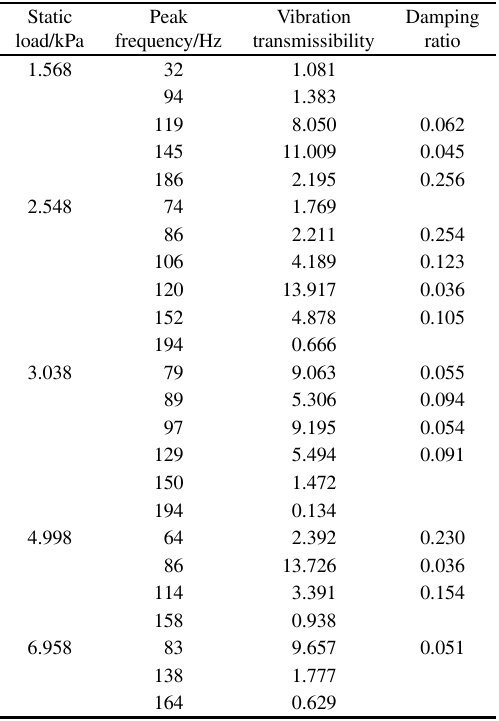
Table 2 Vibration transmissibility of X-PLY(A) corrugated